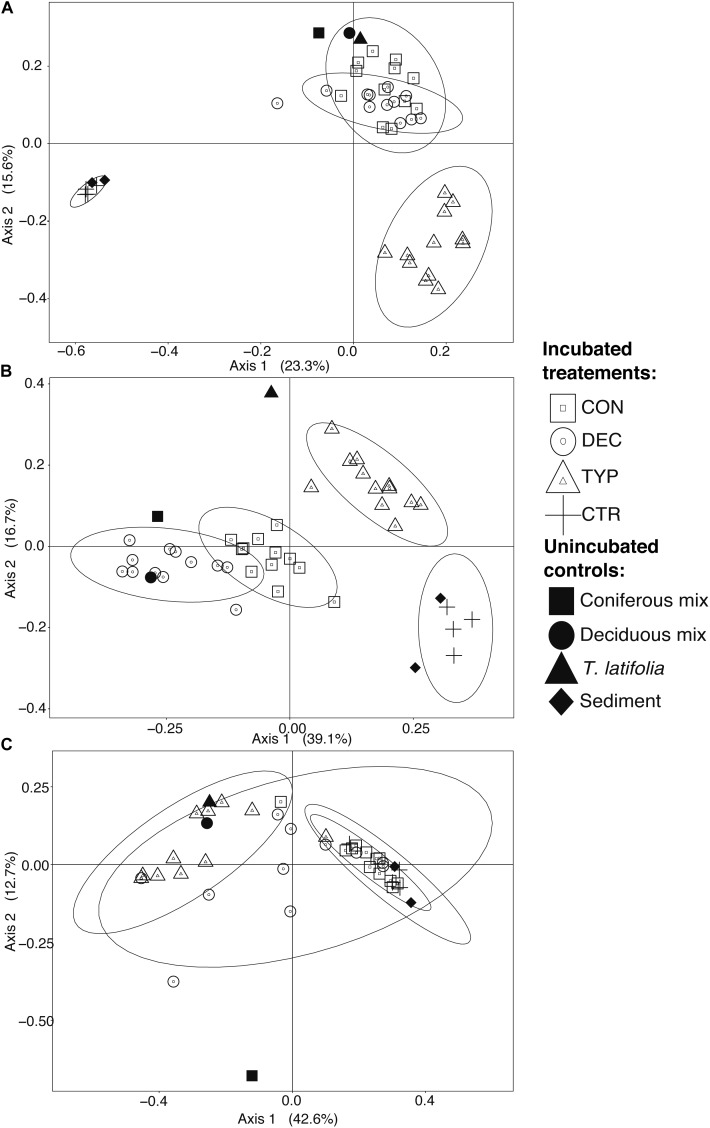
PCoAs of un-weighted UniFrac distances using relative abundances for the respective microbial communities from both un-spiked and spiked samples; bacteria (A; 5565 OTUs), fungi (B; subset of 131 OTUs), and methanogens (C; 43 OTUs), across all treatment concentrations. Ellipses represent 95% confidence intervals which were calculated for each incubated treatment. The proportion of variation explained by each axis is given in parentheses. The pre-incubated sediment is both the un-spiked and spiked sediments.